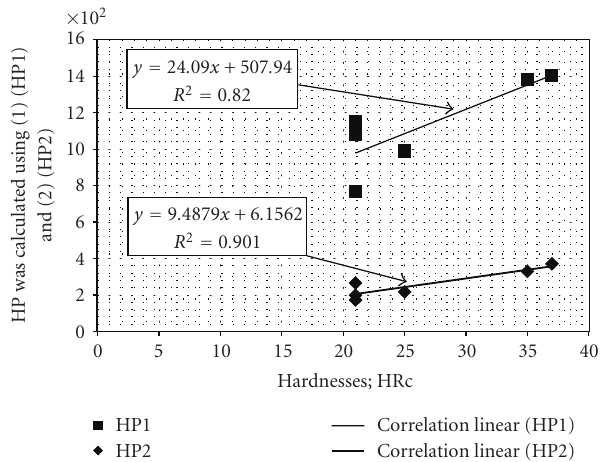
Figure 7: Linear correlation results for core hardnesses obtained on quenched 1045 steel. The upper line was obtained for the HP1 versus HRC correlation and the lower line was obtained for the HP2 versus HRC